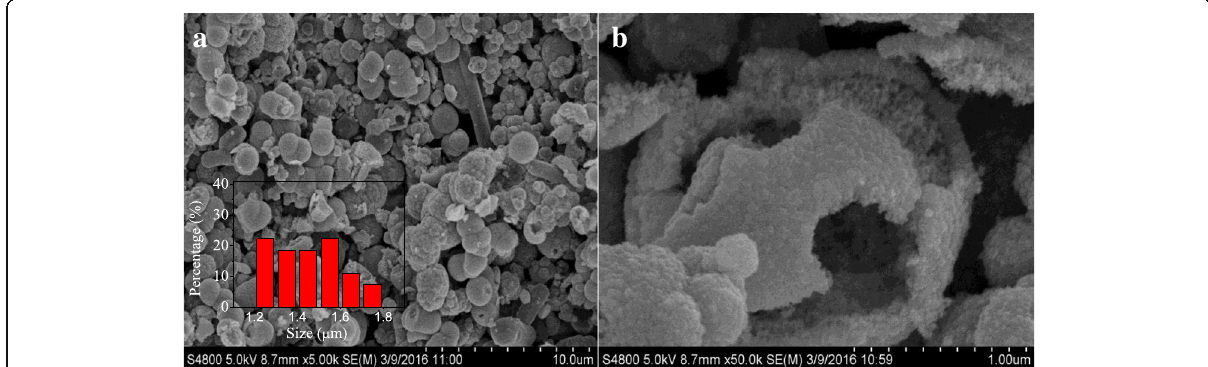
Fig. 1 a A low-magnified SEM image of ZnO@TiO 2 hollow spheres; the inset shows the statistical analysis of diameter distribution of the samples. b A high-magnified SEM image of a single broken ZnO@TiO 2